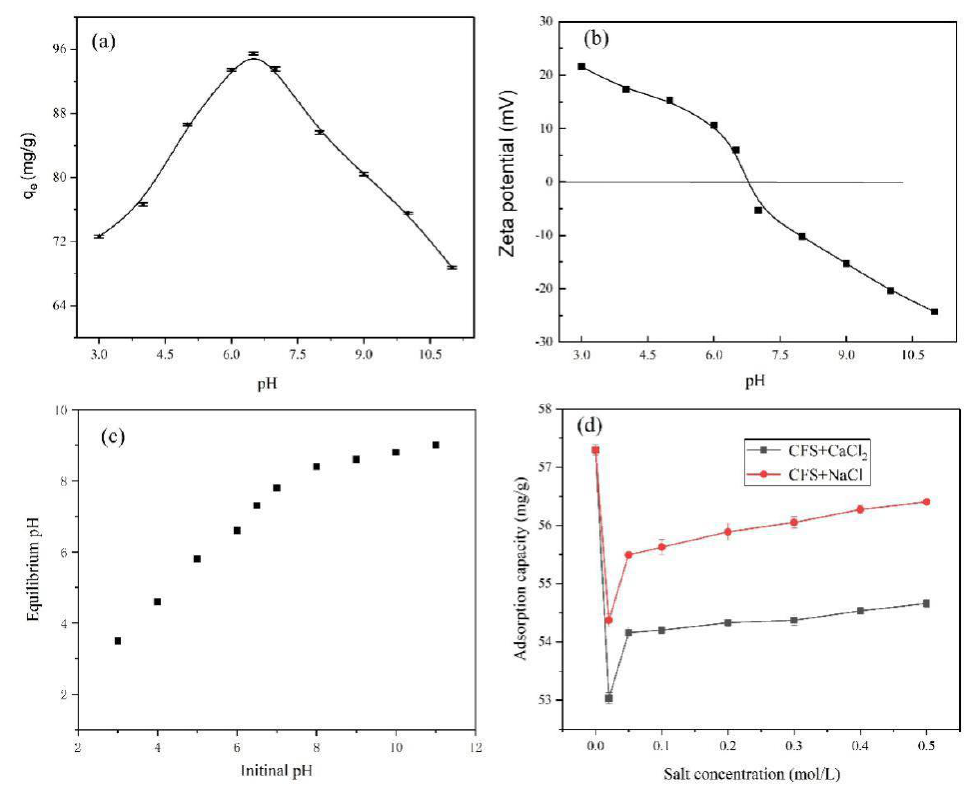
Figure 5. ( a ) Effect of pH on the adsorption capacity, ( b ) zeta potential of CFS adsorbent, ( c ) the recorded initial and equilibrium pH and ( d ) effect of ionic strength on the adsorption capacity (T = 308 K, t = 3 h, C 0 = 150 mg/L, V = 20 mL, m = 30 mg).